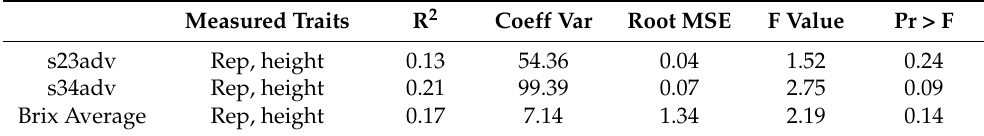
Table 7. Best multiple regression models for the prediction of selection rates and Brix by the field measurements height, diameter, stalk number and estimated